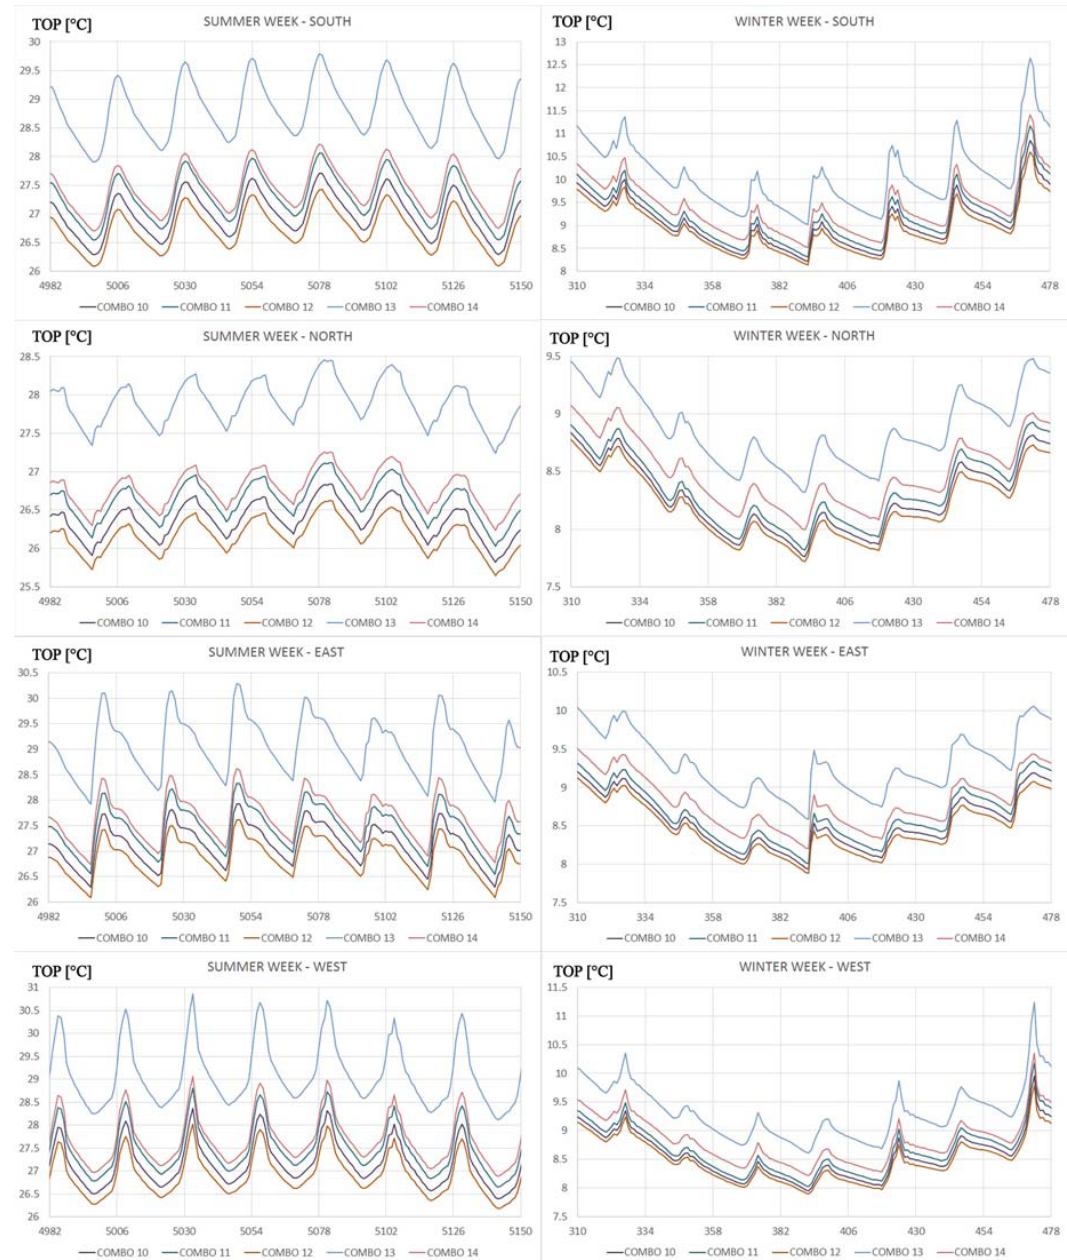
Figure 8. TOP graphical trend for the STEP 5 and STEP 6 (27 July–2 August; 12 January–18 January).